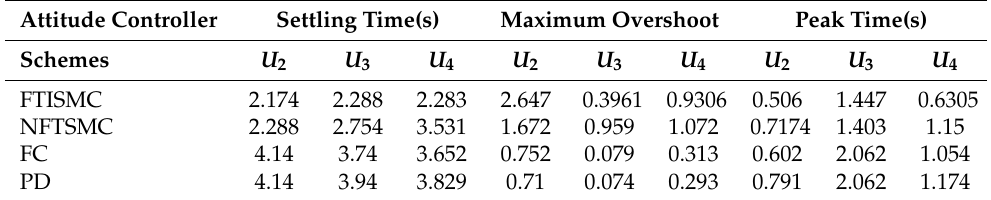
Table 3. Summary and comparison of attitude subsystem controllers performances.